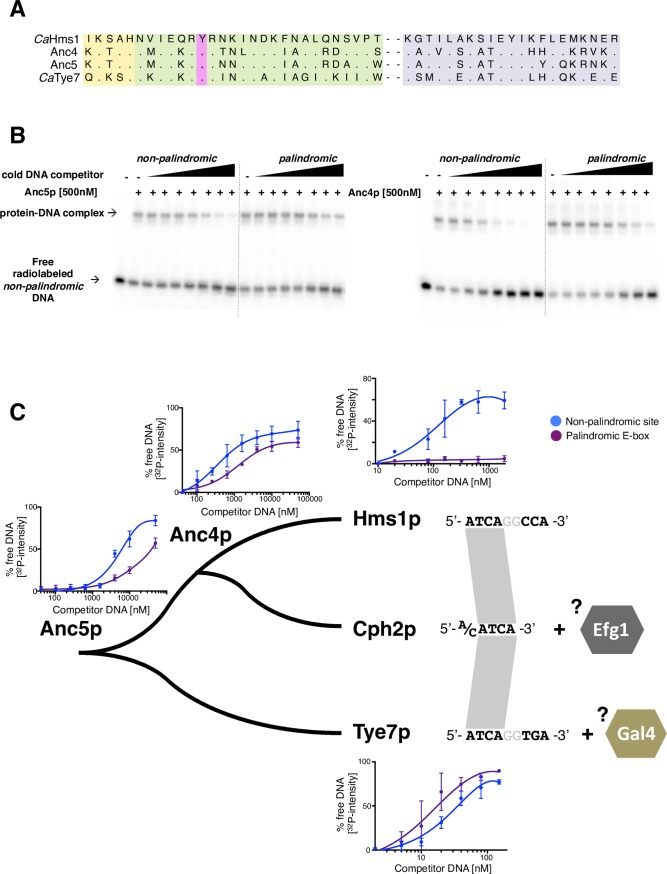
Ancestral protein reconstruction and divergence of DNA binding preferences in fungal SREBPs.(A) Protein sequence of the DNA binding domains of the two ancestors that were reconstructed and synthesized (Anc4 and Anc5). The corresponding sequences for the C. albicans Hms1 and Tye7 proteins are included for comparison. Colour shades represent the same regions of the proteins as in Fig 1A. (B) Competition experiments to determine the DNA binding preferences of Anc5p (left panel) and Anc4p (right panel). Assays were carried out as described for Fig 4B. (C) Diagram depicting the DNA binding preferences in extant and ancestral fungal SREBPs. Shown are the quantifications of in vitro DNA binding competition assays carried out with the two ancestor proteins (gels in Fig 6B), CaHms1p (gels in Fig 4B) and CaTye7p (gels in S5C Fig). At least three independent experiments were quantified for each protein and the means ± S.D. are plotted. The more separation between the blue and the purple line indicates clearer preference for one of the two sequences. Notice that Hms1p shows strong preference for the non-palindromic sequence (blue) whereas Tye7 displays slight preference for the palindromic E-box (purple). To the right are shown the DNA sequences that each protein binds in vivo. Co-factors such as Efg1p and Gal4p may contribute, at least in part, to the specific binding in vivo of Cph2p and Tye7p (discussed in the text).